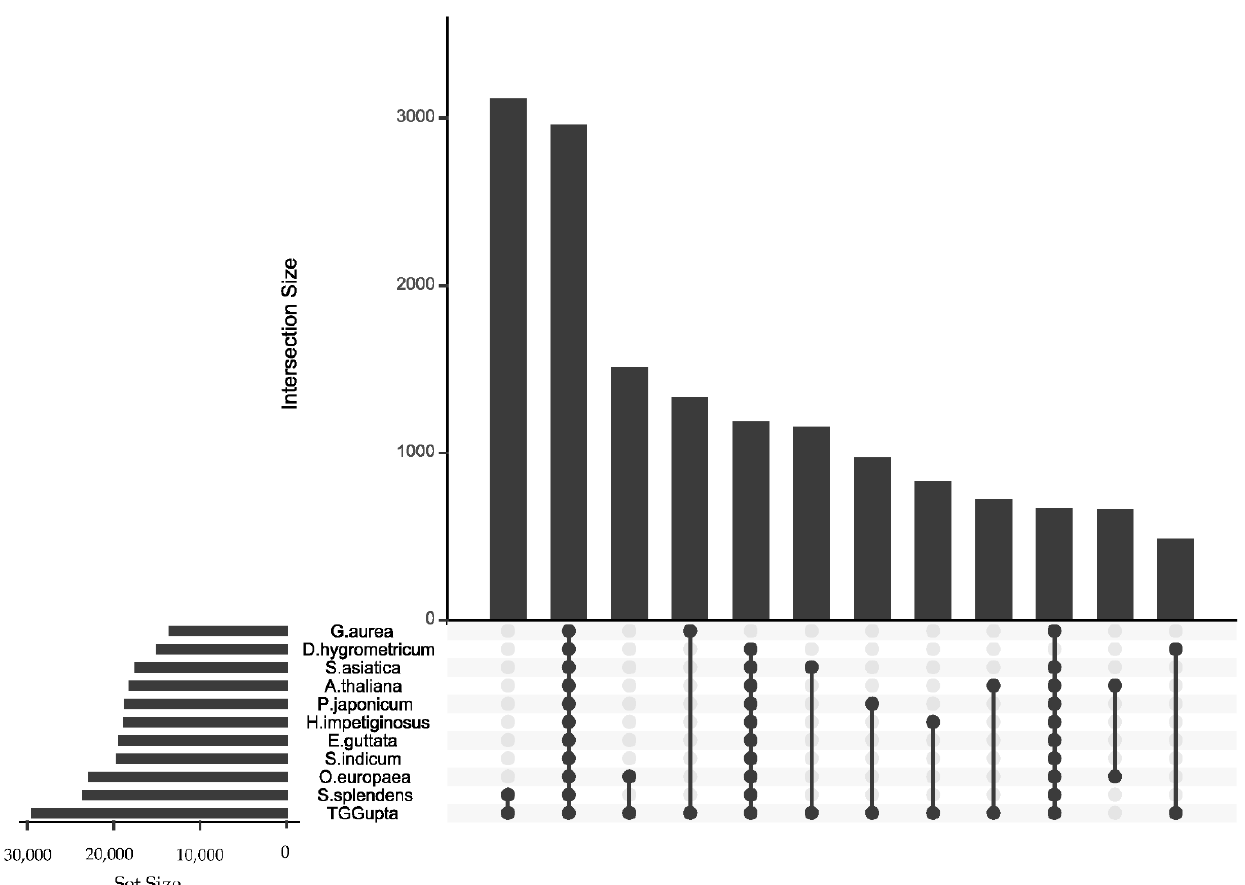
Figure 4. Like Figure 3, this UpSet plot shows the extent of the orthology between sequence databases, but in this case, the diagram visualizes the homology among protein sequences rather than transcript sequences, and the comparison ranged across Lamiales rather than between assembled S. hispanica transcript sequence sets. Clusters of protein sequences found in only one species were excluded. The TGGupta transcript sequence set, when translated to amino acids, showed a strong homology to proteins of other taxa within Lamiales . The number of orthologs found across the entire set of species was almost as large as the number of orthologs found uniquely with its genus-mate Salvia splendens .